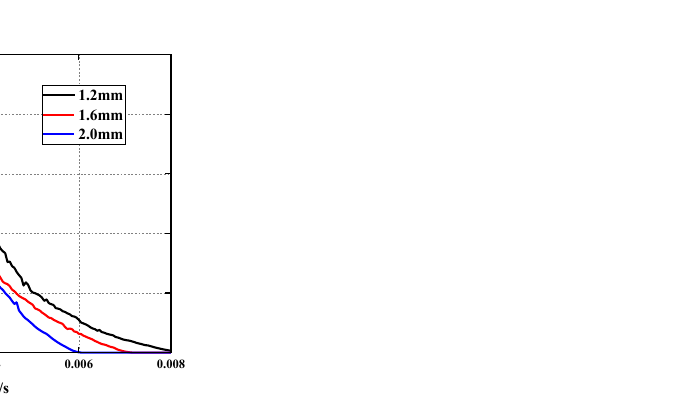
Figure 11. EA and SEA of sandwich panels with different face sheet thicknesses.